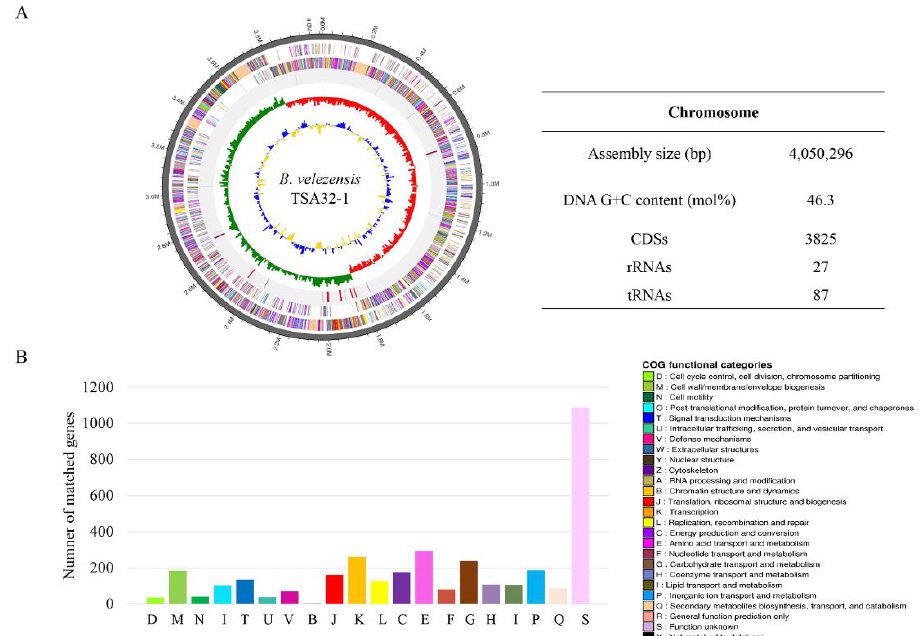
Figure 6. Genome features of Bacillus velezensis TSA32-1. ( A ) Circular genome maps of B. velezensis TSA32-1 chromosome. Circles from the outside to the center denote rRNA and tRNA gene, reverse strand coding sequence, forward strand coding sequence, GC skew, and GC content. ( B ) Genome number of clusters of orthologous groups category.